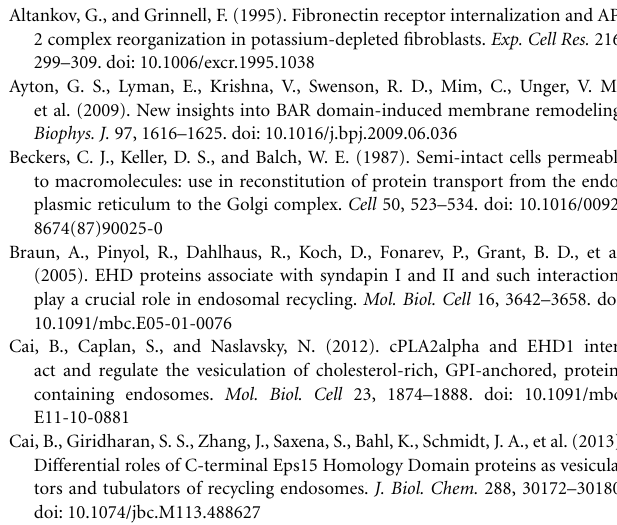
HA-GRAF1c. After 48h, cells were lysed for 1h in buffer containing 50mM Tris pH 7.4, 150mM NaCl, 0.5% Triton X-100 and protease inhibitors. Cell lysates were incubated with mouse anti-MICAL-L1 antibody or rabbit EHD1 antibody overnight. Protein L beads (D) or Rabbit IP Matrix beads (E) were added to the mixture of cell lysate and MICAL-L1 or EHD1 antibody for 3h at 4 ◦ C. Beads were washed in buffer containing 50mM Tris pH 7.4, 150mM NaCl, 0.1% Triton. Proteins were eluted by adding SDS loading buffer. Samples were subjected to 8% SDS-PAGE, followed by blotting with anti-HA and either anti-MICAL-L1 or EHD1 antibodies. Figure S2 | GRAF1-containing tubular recycling endosomes are positive for phosphatidic acid. (A–C) HeLa cells were cotransfected with HA-GRAF1 and the phosphatidic acid-binding yeast protein, GFP-SPO-20. Insets show that SPO-20 localizes in part to GRAF1-containing tubular endosomes. (D) Mock- or GRAF1-depleted cells were transfected after 48h treatment with either wild-type or siRNA-resistant HA-GRAF1c for an additional 24h. Lysates were then separated by SDS PAGE and immunoblotted with anti-HA or anti-actin antibodies. Bar, 10 μ m. Figure S3 | The tubular localization of the GRAF1c BAR-PH domains do not require MICAL-L1 or Syndapin2 expression. (A,B) Cells grown in 35mm dishes were either mock-treated, treated with (A) MICAL-L1-siRNA or (B) Syndapin2-siRNA for 72h. After lysis, cell lysates were subjected to 8% SDS-PAGE, followed by immunoblotting with anti-MICAL-L1, Syndapin2 and Actin antibodies. (C–E) In the last 20h of siRNA-treatment, cells were transfected with HA-GRAF1c (BAR-PH). After fixation, cells were stained with rabbit anti-HA antibody, followed by Alexa-488 goat anti-rabbit secondary antibody. (F,G) Cells were treated with Mock- or Dynamin2-SiRNA for 48h, and then fixed and stained with anti-MICAL-L1. Efficacy of Dynamin2 depletion was demonstrated by its impact on transferrin uptake (data not shown). Bars, 10 μ m. Figure S4 | The GRAF1c BAR-PH domains are unable to vesiculate MICAL-L1-containing tubules. (A) Purified GST and GST-GRAF1c (BAR-PH) proteins were detected by SDS-PAGE and Coomassie Blue staining. Cells were permeabilized with 20 μ g/ml digitonin for 40s at room temperature. Permeabilized cells were either incubated with (B) GST-only and (C) GST-GRAF1c (BAR-PH) for 30min. at 37 ◦ C. Cells were then fixed and stained with anti-MICAL-L1 antibody. Bar, 10 μ